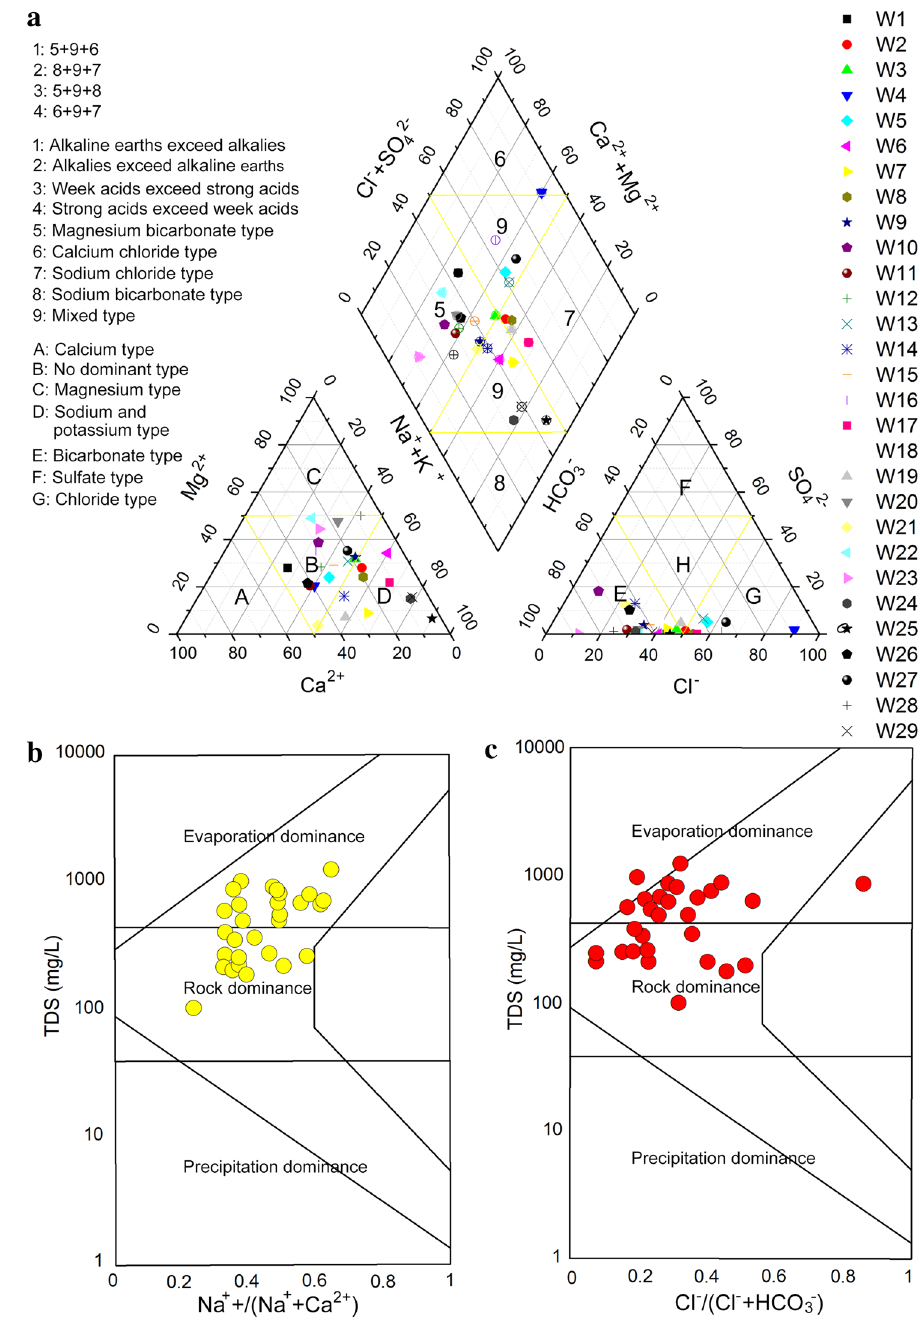
Fig. 10 Piper diagram and Gibbs plot to assess the major process controlling groundwater chemistry a Hydrochemical classification of the ground- water samples using Piper dia- gram, b Gibbs plot for cations and c Gibbs plot for